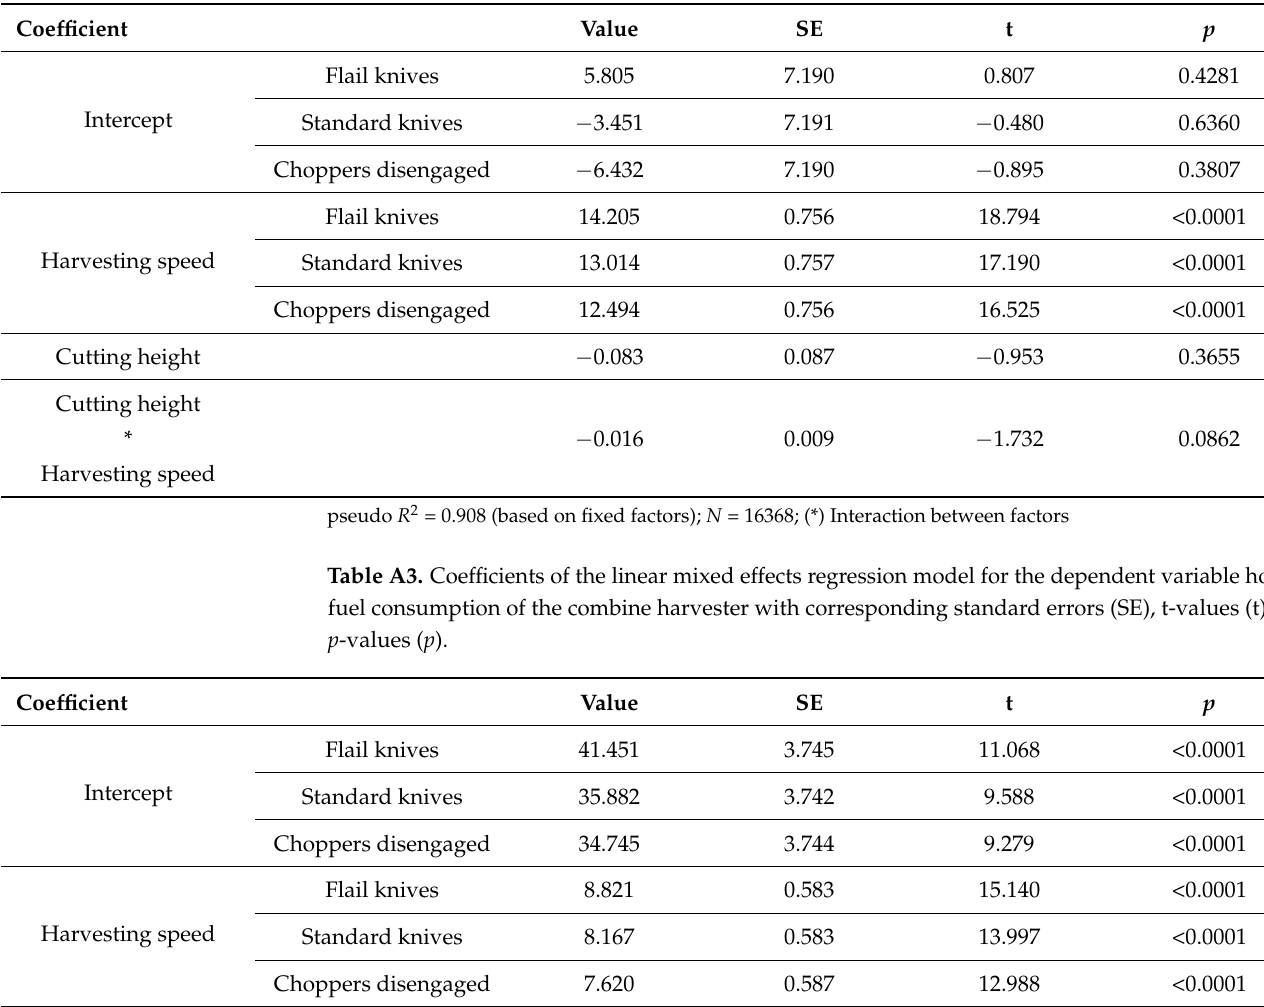
Table A2. Coefficients of the linear mixed effects regression model for the dependent variable engine load of the combine harvester with corresponding standard errors (SE), t -values ( t ) and p -values ( p ).